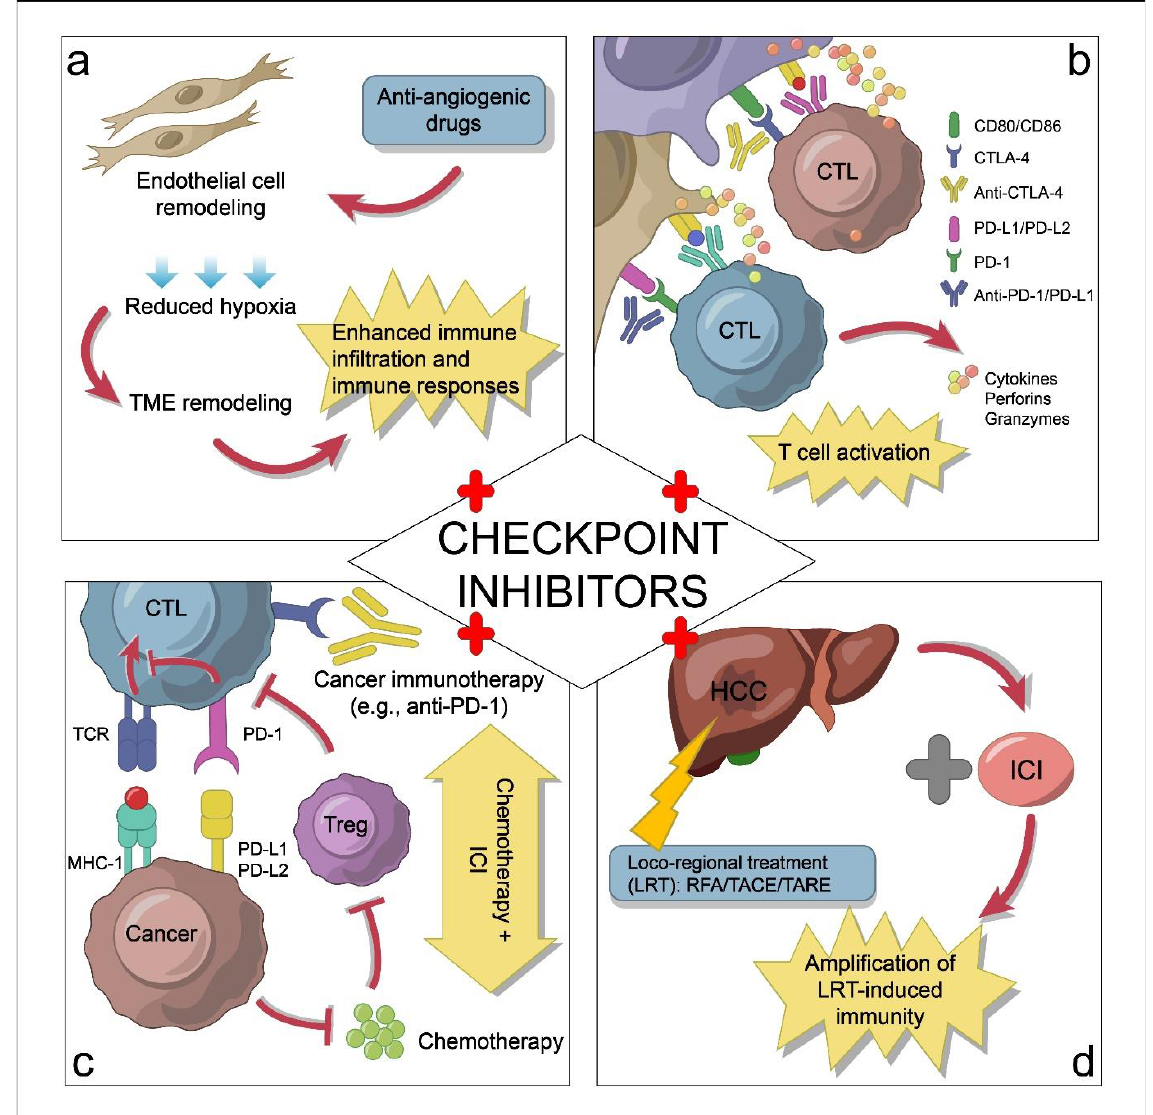
Figure 2. Schematic illustrations of how immune checkpoint inhibitors (ICIs) interact with other forms of treatment as combinatorial therapeutic strategies for hepatocellular carcinoma (HCC) treat- ment. ( a ). Combining ICIs with anti-angiogenic drugs (e.g., anti-VEGF) blocks HCC angiogenesis and boosts anti-tumor immune responses. ( b ). Dual ICIs that target non-redundant pathways of T cell inactivation (e.g., PD-1 and CTLA-4 pathways) outperform single-agent ICI therapy. ( c ). Adding chemotherapeutic drugs to ICIs promotes immunogenic cell death by activating dendritic cells, in- creasing T cell cross-priming, and suppressing myeloid-derived suppressor cells (MDSCs) and reg- ulatory T cells (Tregs), which collectively boosts anti-tumor immunity. ( d ). Combining ICIs with neoadjuvant or adjuvant therapies can upregulate HCC antigens (e.g., glypican 3 and AFP), thereby enhancing immunotherapy efficacy. Abbreviations in this figure: CTL, cytotoxic T lymphocyte; MHC-1, major histocompatibility complex class I; RFA, radiofrequency ablation; TACE, transarte- rial chemoembolization; TARE, transarterial radioembolization; TCR, T cell receptor; TME, tumor microenvironment.